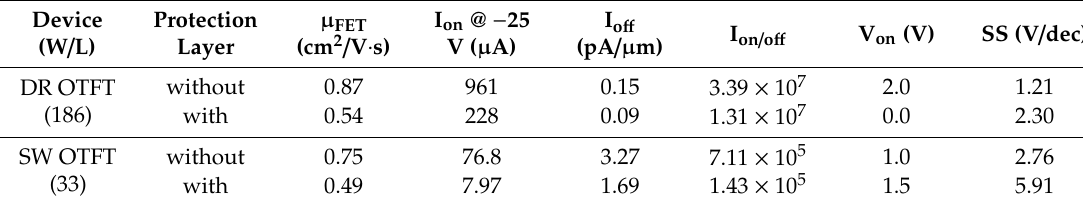
Figure 5. The transfer curves of the DR and SW OTFTs with and without the protection layer in the test pixel; the performance was degraded by the protection layer; however, the on-state current was still large enough to drive the enlarged OLED of the stacked pixel. Table 2. The average values of the electrical parameters of the DR and SW OTFTs in the stacked pixel with and without the protection